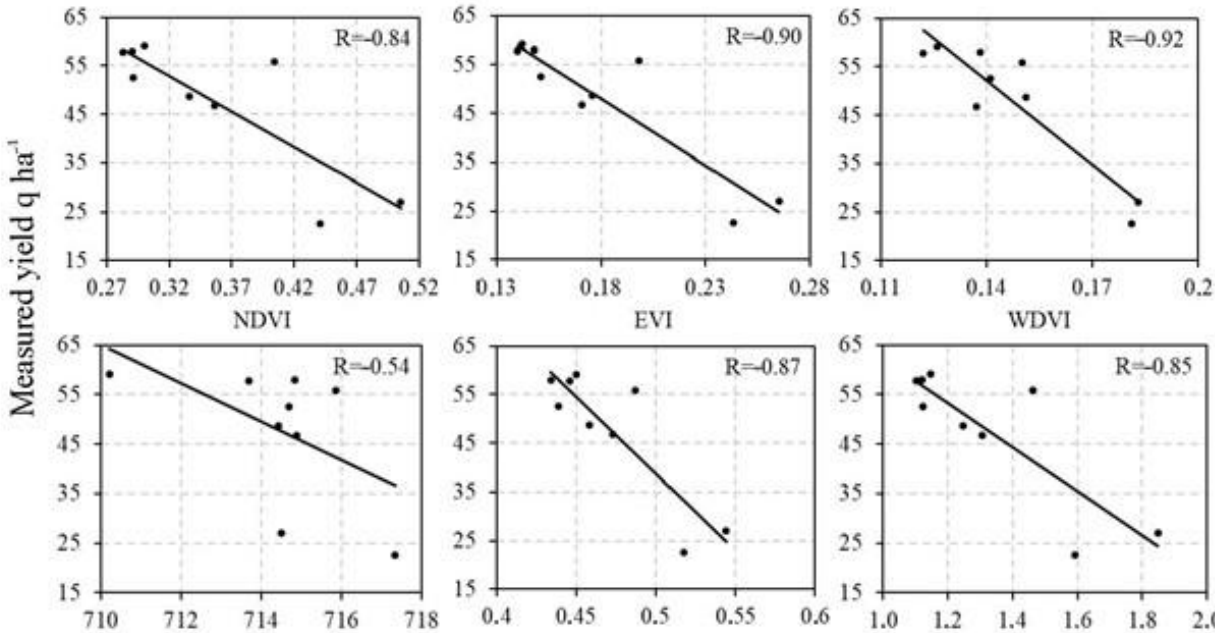
Figure 4. Correlations of remote sensing indices with in-situ yield. Durum wheat plant phenological stages.